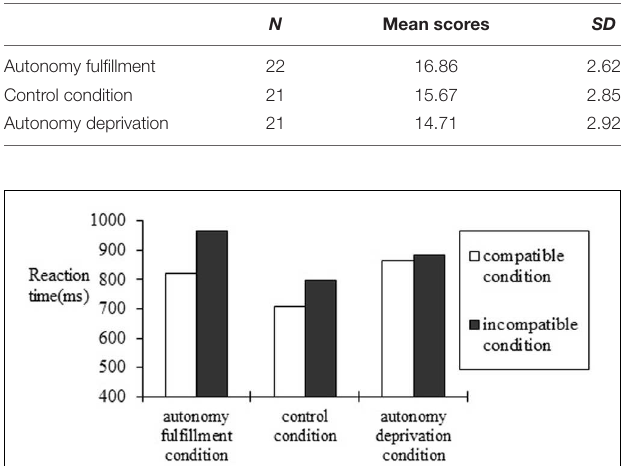
FIGURE 1 | Reaction time of compatible and incompatible evaluation conditions under the autonomy fulfillment, autonomy deprivation, and control condition in Study